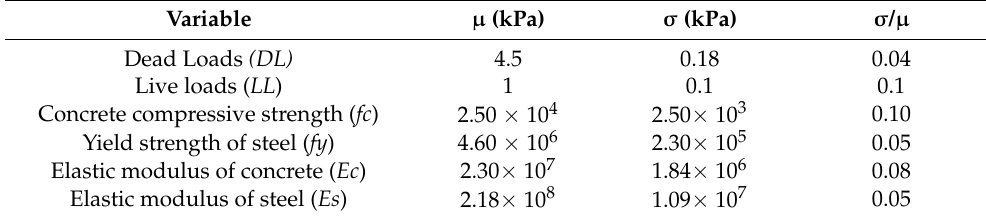
Table 1. Mean, µ , standard deviation, σ , and coefficient of variation, σ / µ , of the random variables. Variable µ (kPa) σ (kPa) σ / µ Dead Loads (DL) 4.5 0.18 0.04 Live loads ( LL ) 1 0.1 0.1 Concrete compressive strength ( fc ) 2.50 × 10 4 Yield strength of steel ( fy ) Elastic modulus of steel ( Es